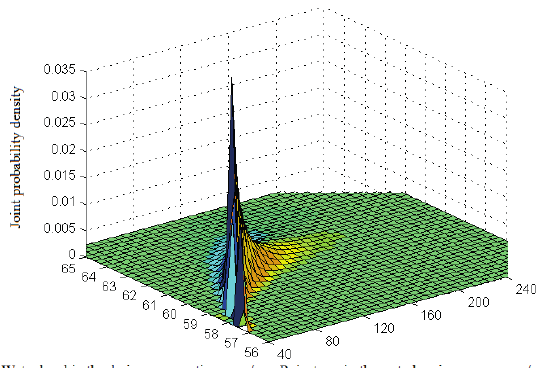
Fig. 2 The joint probability density distribution maps of the two